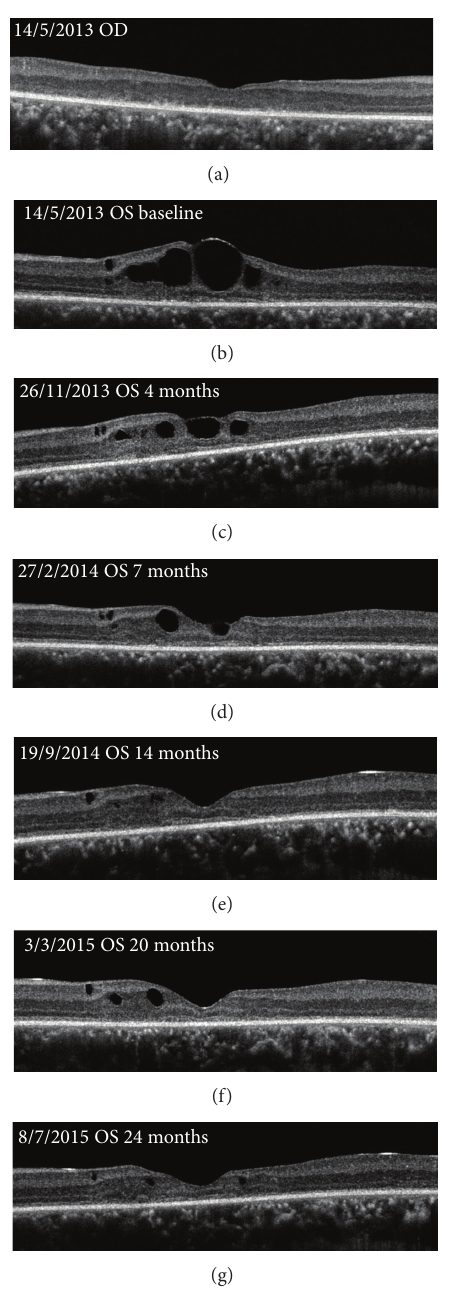
Figure 4: Time course of foveoschisis in SD-OCT images from the baseline is shown. (a) Baseline OCT image (180 ∘ ) of the right eye showing central atrophy and a thinning of the entire retina. (b) Baseline OCT image (180 ∘ ) of the left eye showing foveoschisis mainly in inner nuclear layer. The ellipsoid and interdigitation zones are not visible in the fovea of both eyes. (c) OCT image of the left eye after 4 months of treatment with dorzolamide. (d) OCT image of the left eye 7 months later. (e) OCT image of the left eye 14 months later. (f) OCT image of the left eye 20 months later. (g) OCT image of the left eye 24 months